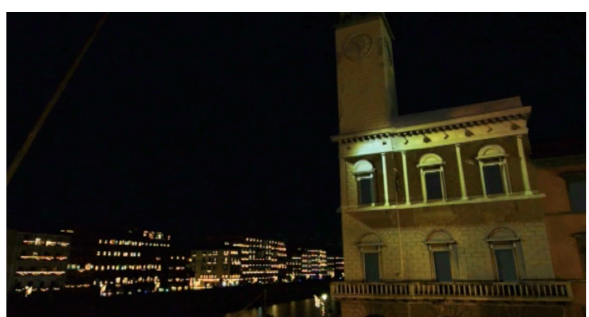
Figure 1. Videomapping for the Luminara (Pisa